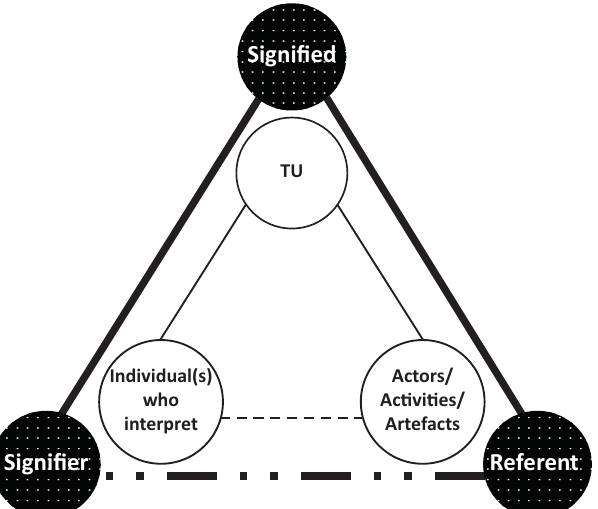
Figure 3. Semiotic Triangle and equivalent TU components.